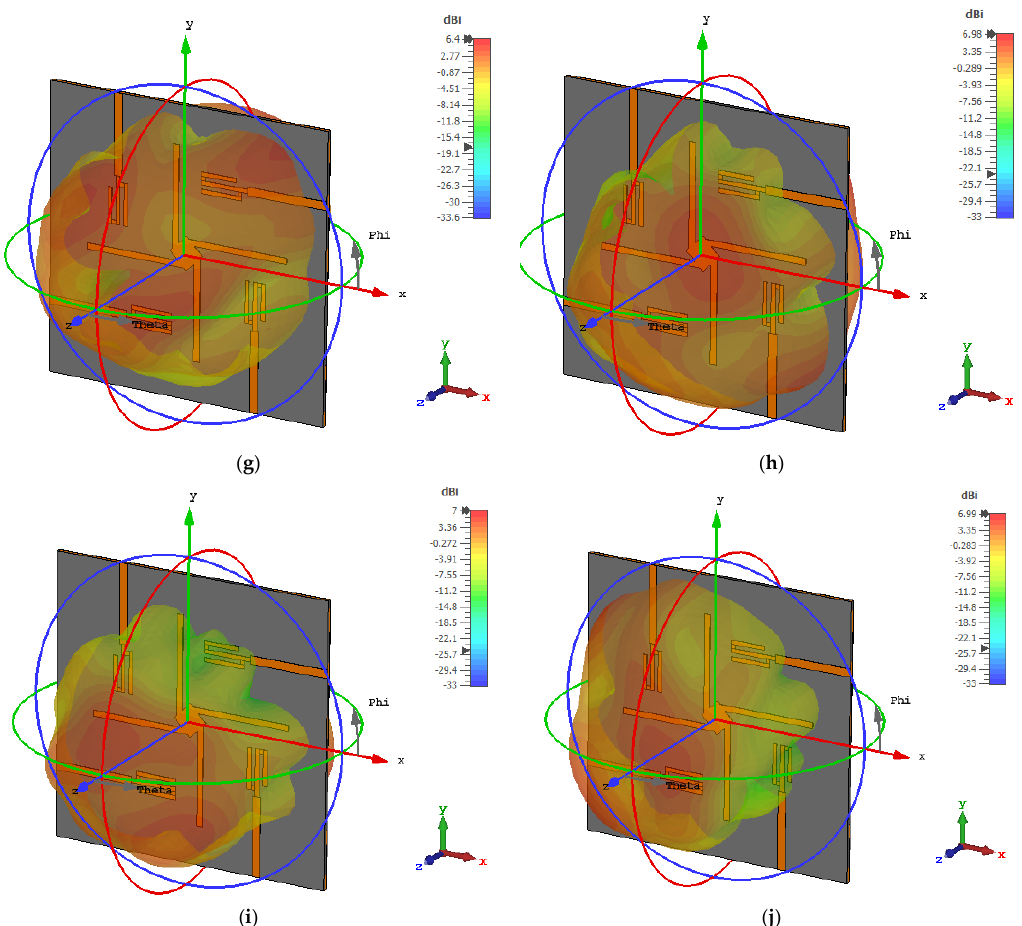
Figure 10. Radiation Patterns ( a ) 2D antenna 1 and antenna 2 Phi90 ( b ) 2D antenna 3 and antenna 4 Phi90 ( c ) 2D antenna 1 and antenna 2 Theta 90 ( d ) 2D antenna 3 and antenna 4 Theta90 ( e ) 2D antenna 1 and antenna 2 Phi0 ( f ) 2D antenna 3 and antenna 4 Phi0 ( g ) 3D antenna 1 ( h ) 3D antenna 2 ( i ) 3D antenna 3 ( j ) 3D antenna 4. MIMO Parameters